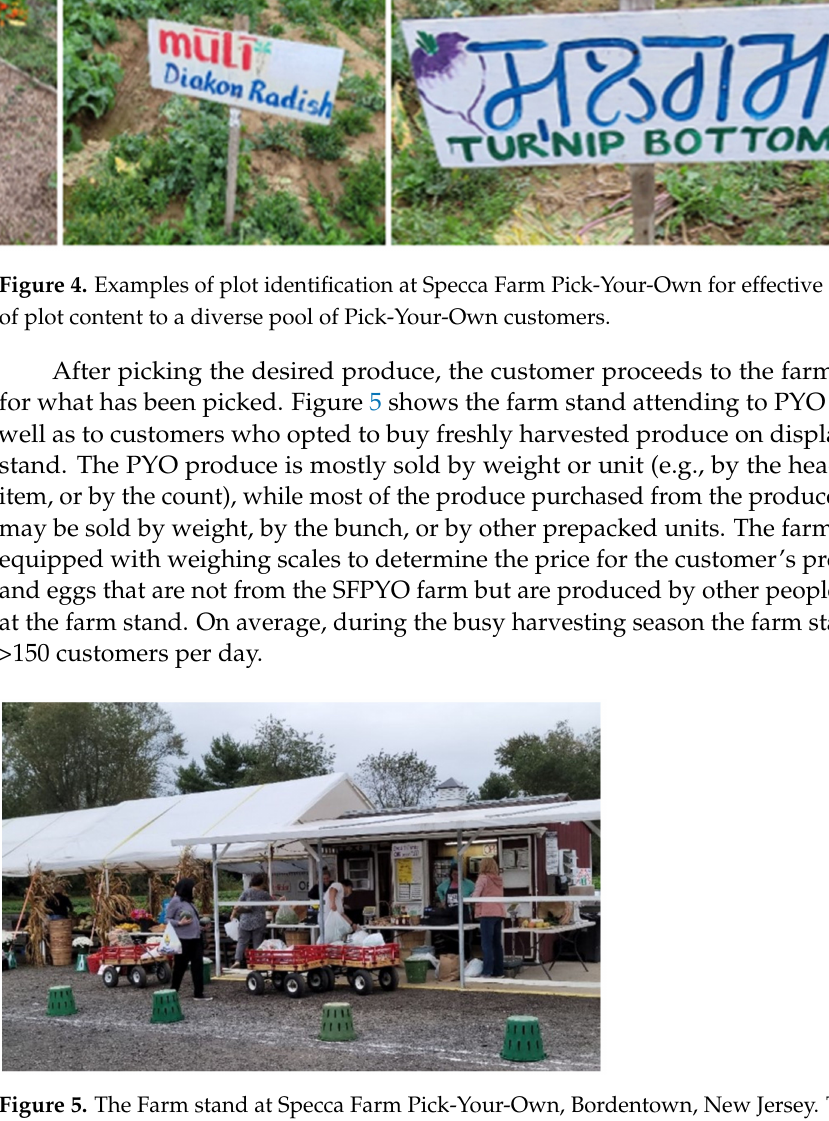
Figure 5. The Farm stand at Specca Farm Pick-Your-Own, Bordentown, New Jersey. To the left is the produce shed where customers may purchase some vegetables; to the right is the scalehouse where the customer’s PYO and farm market produce are processed for